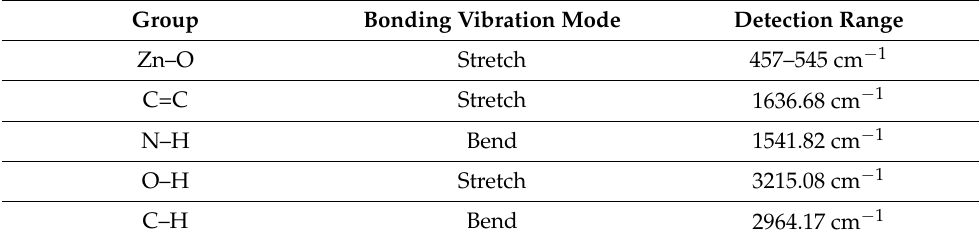
Table 1. Values of the FTIR spectrum bands of the investigated